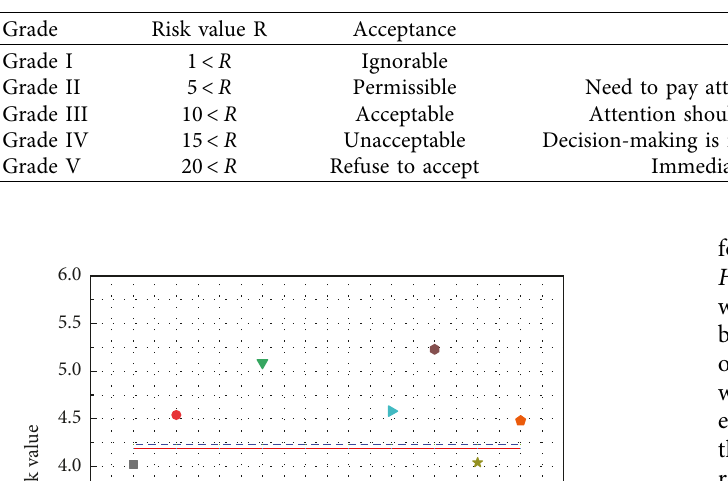
Table 23: Risk classification